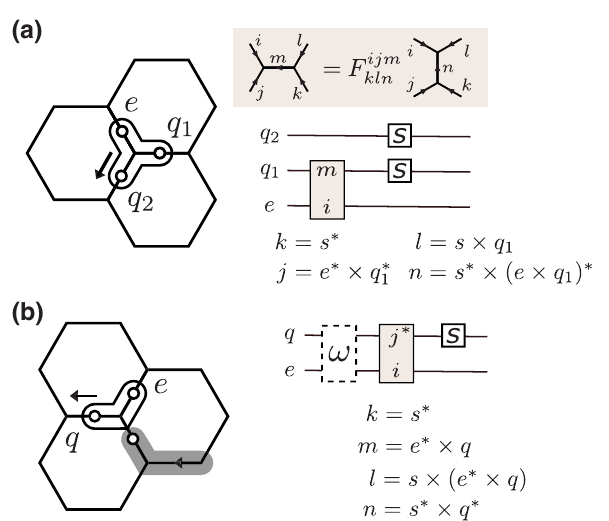
FIG. 13. The quantum circuits for Abelian open-string opera- tors. (a) A circuit realization for preparing Abelian anyons. The shaded box shows the F move defined by the F symbol in the Abelian model, together with the labeling convention for the F symbol. We define the shaded circuit element to associate the qudit state with an F -symbol phase. This phase is computed based on the F -symbol labels assigned in the circuit diagram (see also the discussion in Appendix E). (b) A circuit realization for moving the Abelian anyons by extending the string operator (dark gray).